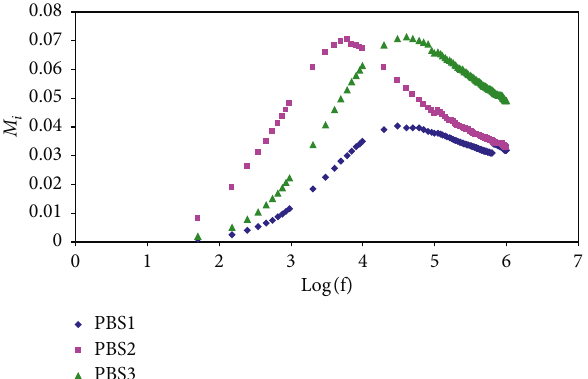
Figure 11: Imaginary part ( M i ) of electric modulus versus fre- quency at ambient temperature for CS:POZ blend